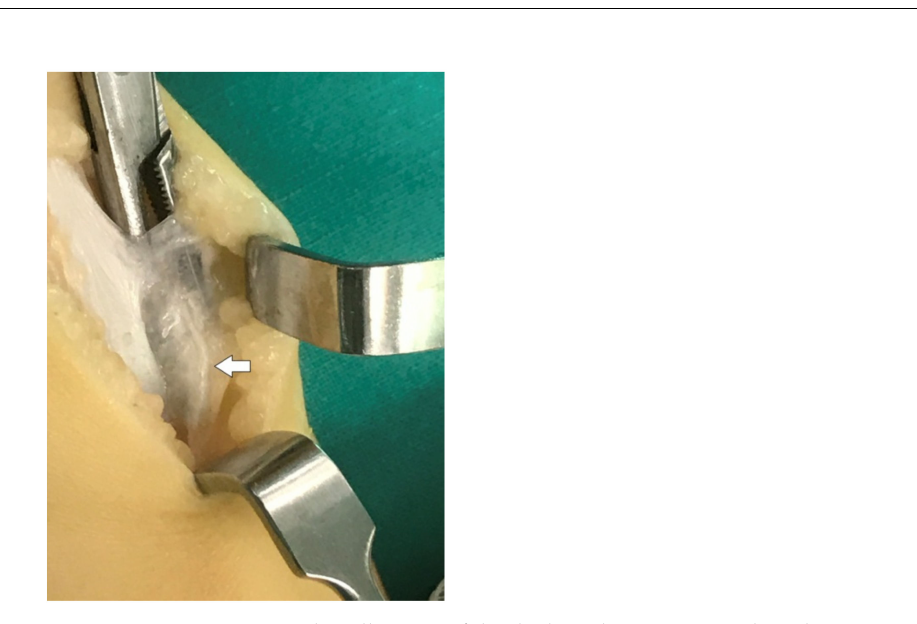
Figure 2. Arrow points to the adhesions of the thickened paratenon to the subcutaneous